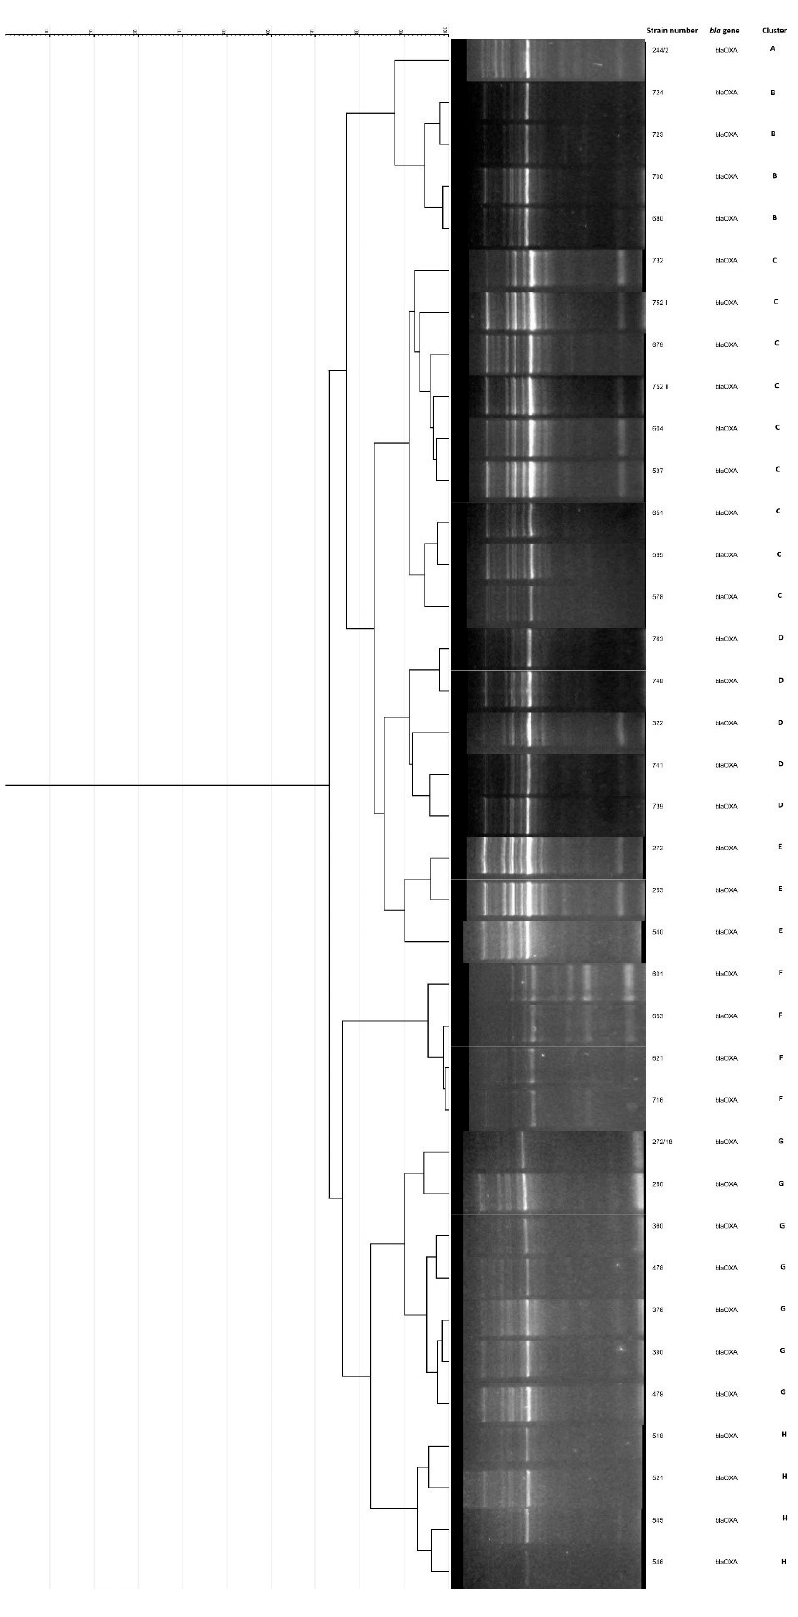
Figure 2. Dendrogram and gel image obtained by ERIC-PCR analysis of bla OXA-48 -positive (N = 37) Klebsiella pneumoniae isolates. Eight different clusters (A–H) were generated at the similarity level of 90%. ERIC-PCR, Enterobacterial Repetitive Intergenic Consensus PCR.